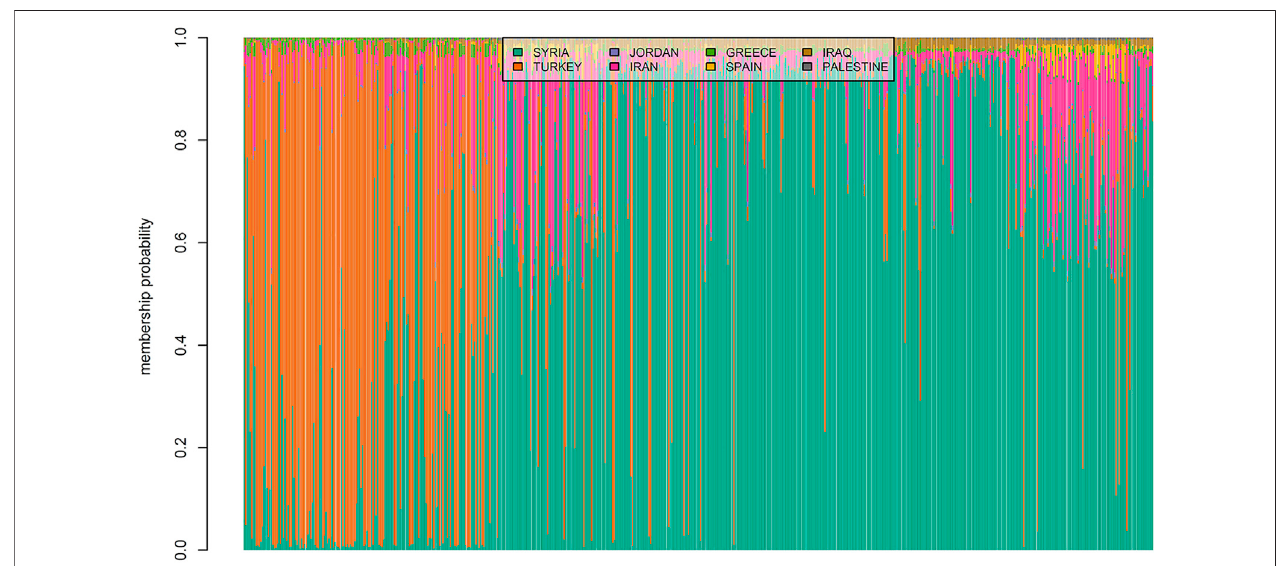
FIGURE 6 | Estimated population membership probability of 600 bread wheat landraces from eight countries where each bar represents a landrace.